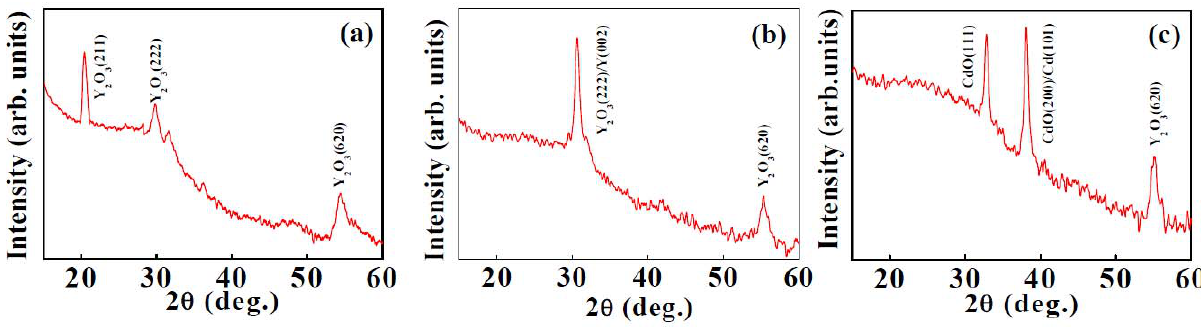
O coating, ( b ) thermally 2 3 O 2 3